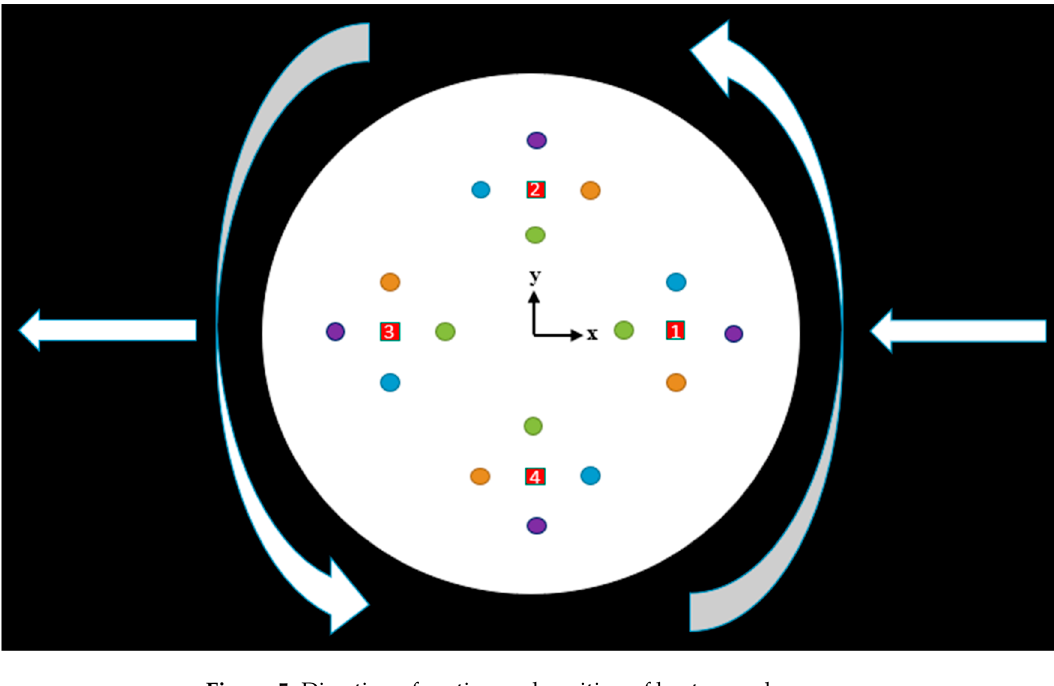
Figure 5. Direction of motion and position of heaters and sensors.